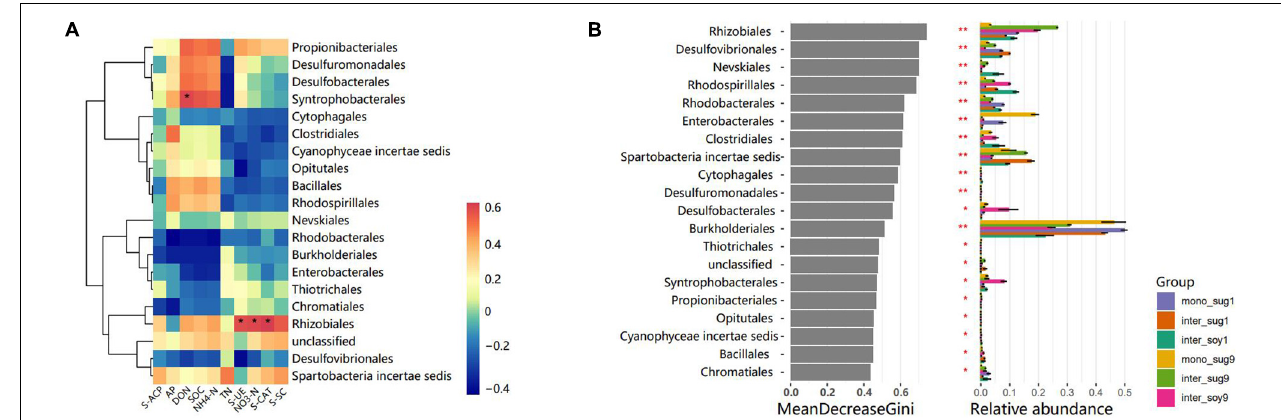
FIGURE 4 | (A) Pearson correlation heat maps of environmental factors and relative abundances of the 20 most abundant bacterial genera in rhizosphere soil samples. (B) Top 10 bacterial genera and their mean decrease in Gini, which is a measure of characteristic correlation. The higher the index of mean decrease Gini, the more important the bacterial genera are.